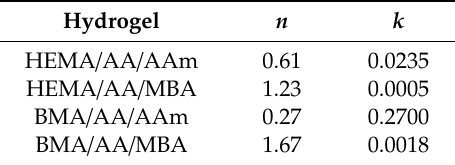
Table 2. Estimated parameters obtained from fitting the ca ff eine release experimental data at pH 4 to the Ritger–Peppas